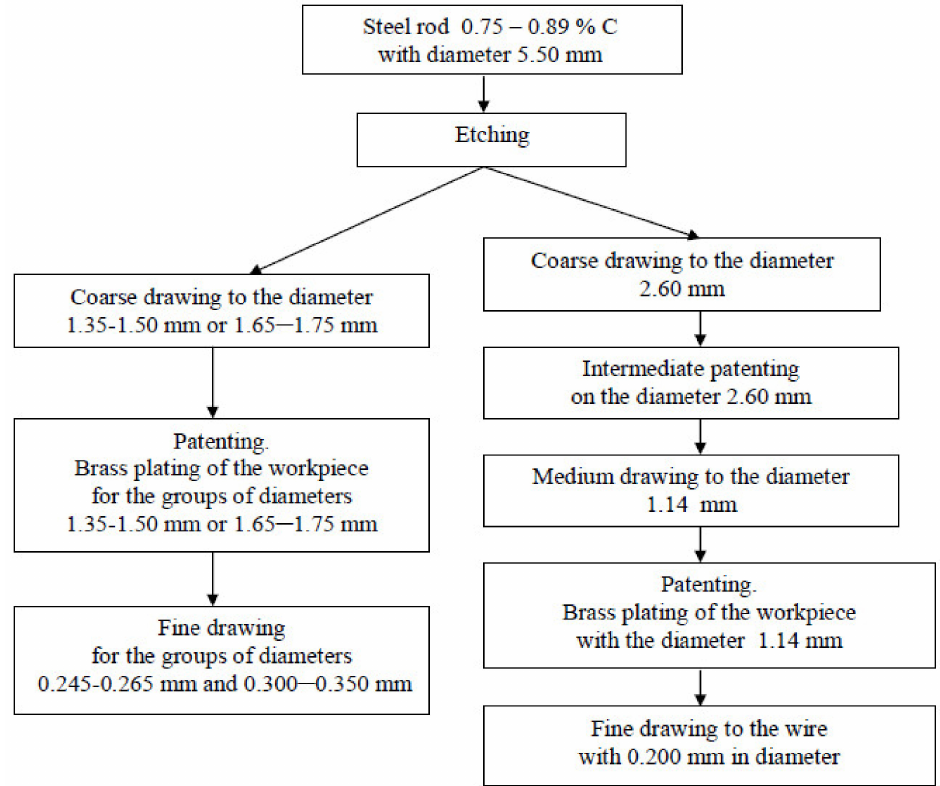
Figure 5. Technological scheme for the manufacture of brass-plated, high-carbon steel wire with high strength for steel